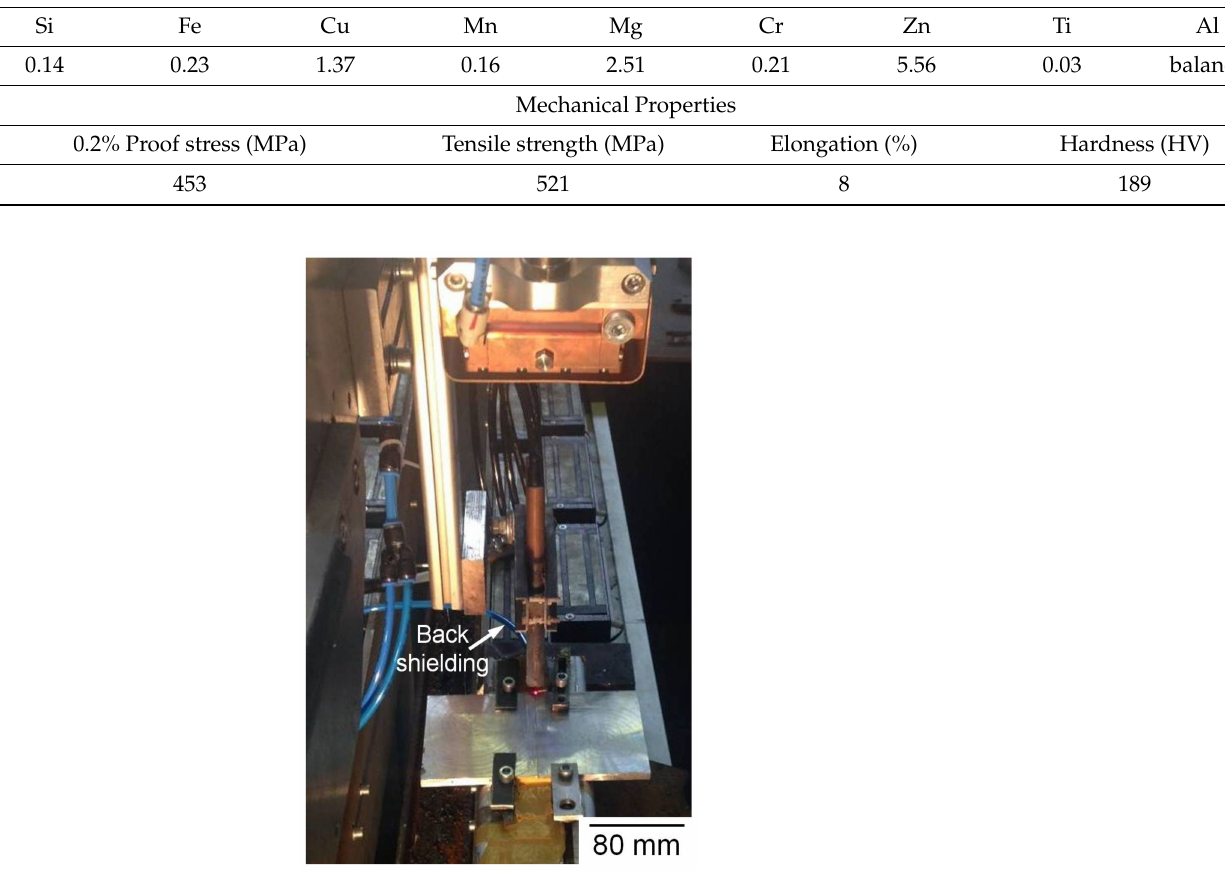
Figure 1. Experimental setup of laser beam welding. Table 2. Welding parameters used for laser beam